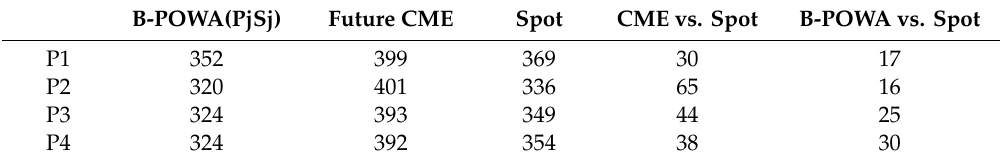
Table 7. Results of the Bonferroni probabilistic ordered weighted average (B-POWA). B-POWA(PjSj) Future CME Spot CME vs. Spot B-POWA vs. Spot P1 352 399 369 401